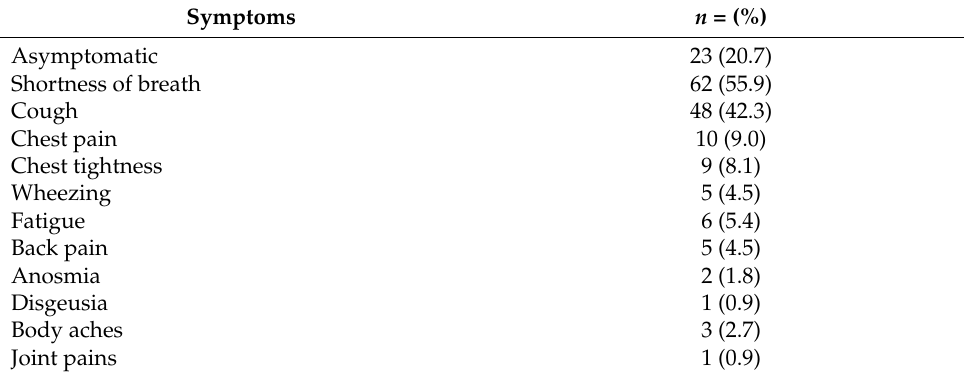
Table 3. Symptoms on presentation to the post-COVID-19 pulmonary clinic.